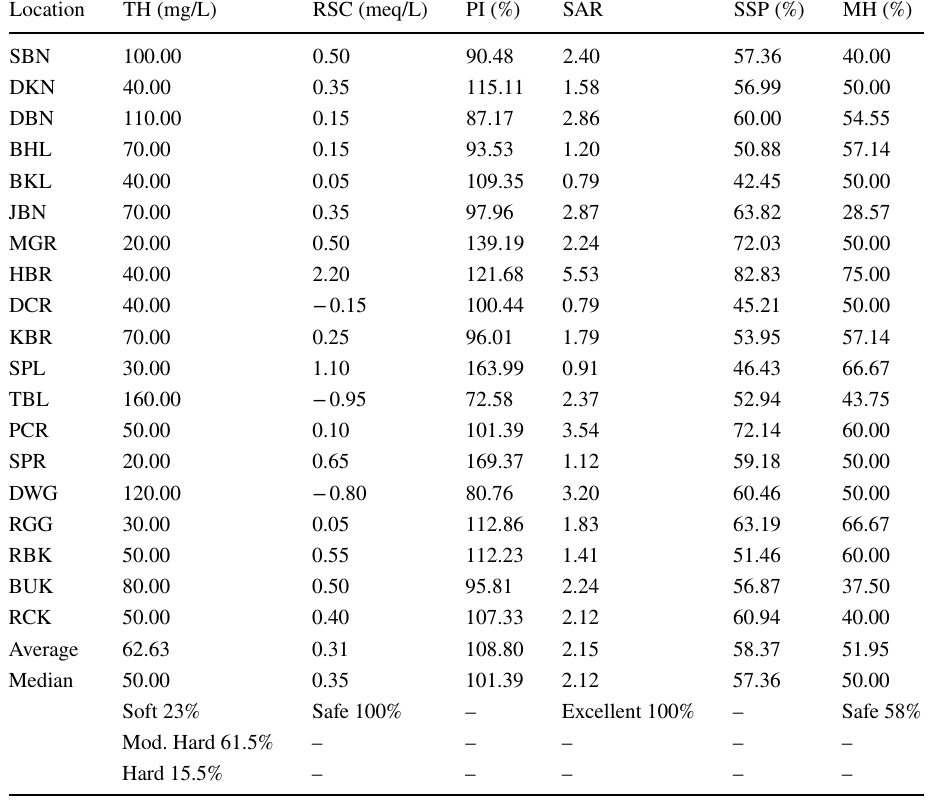
Table 4 Showing the values of irrigation parameters of groundwater of the study area